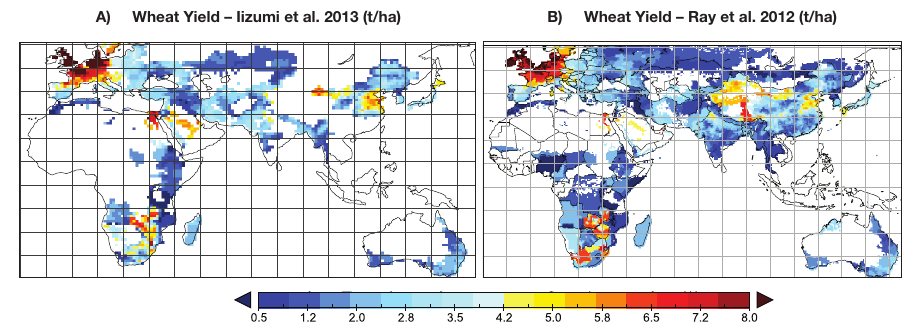
Figure 4. Example of historical evaluation data for year 2000 wheat yields from (a) Iizumi et al. (2013) (at 1.125 ◦ spatial resolution) and (b) Ray et al. (2012) (aggregated from 5 arc minutes to 0.5 ◦ ).